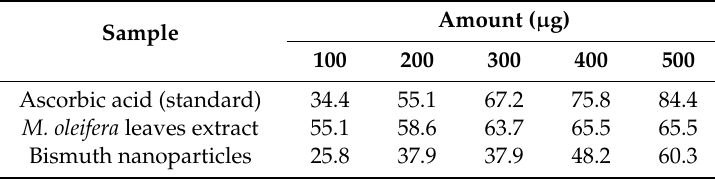
Table 3. Antioxidant activity percentage (AA%) using DPPH assay.